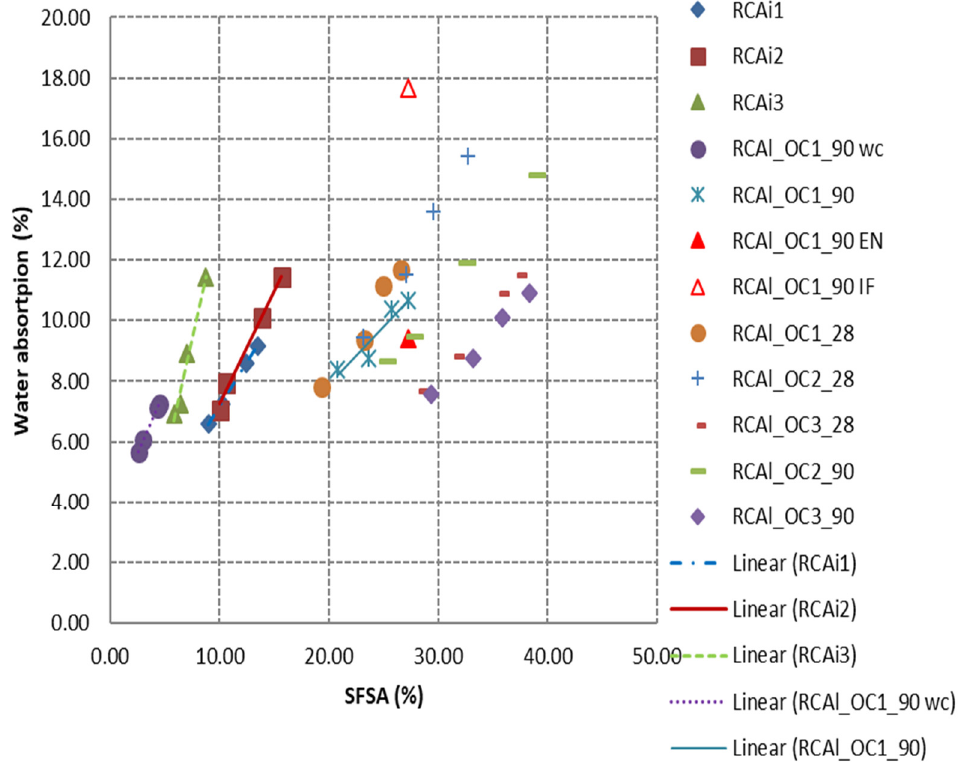
Figure 11. Correlation between water absorption (IFSTTAR method) and SFSA for all studied